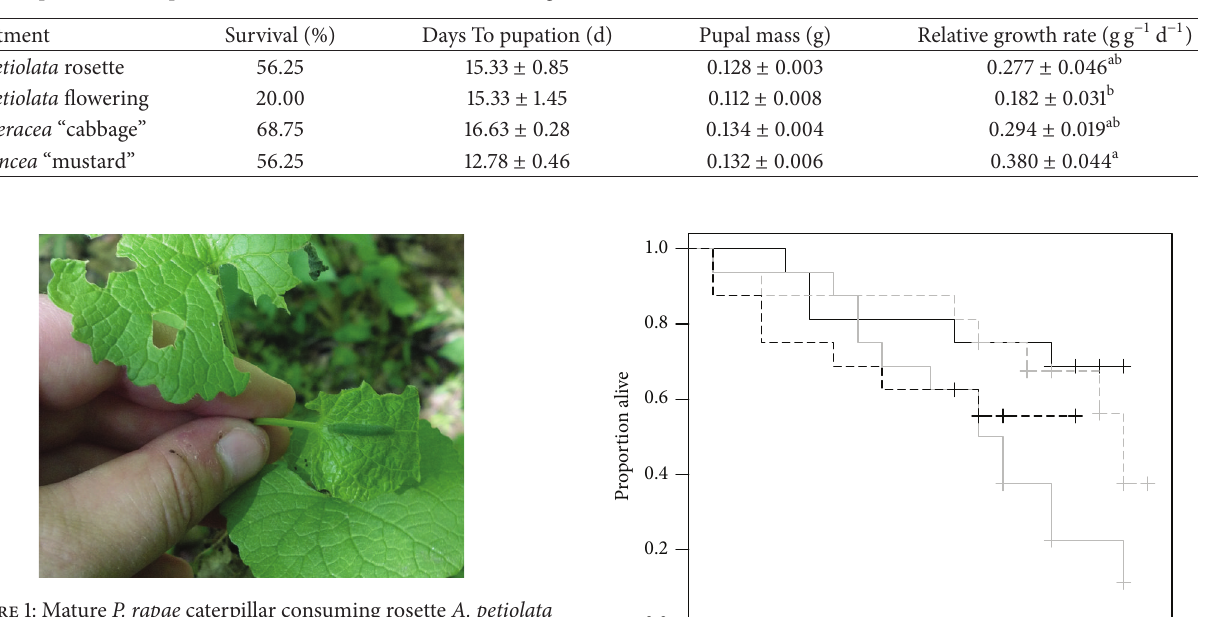
Table 1: Mean percent survival, days to pupation, pupal weight, and relative growth rate with standard error of P. rapae (both sexes) between four host plants ( 𝑛 = 16 per treatment). Different letters indicate significant differences ( 𝑃 < 0.05 ).